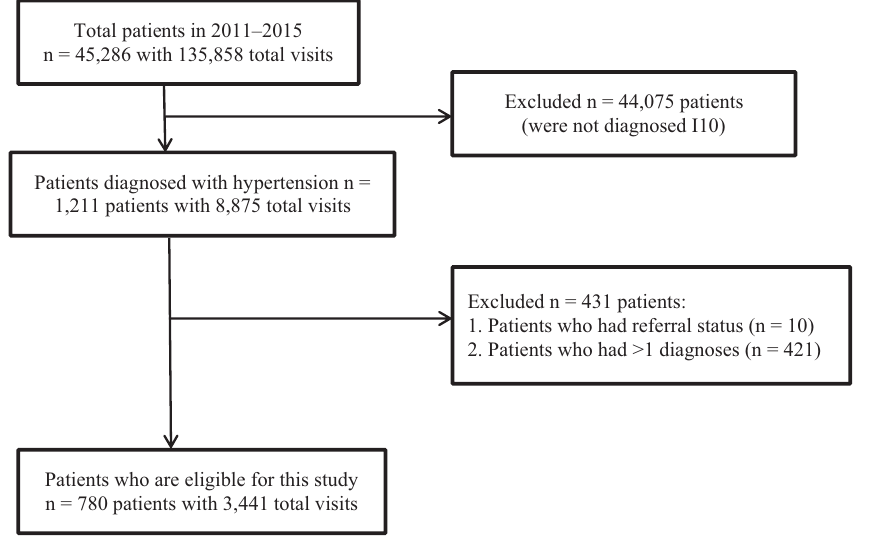
Patients who are eligible for this study n = 780 patients with 3,441 total visits Figure 1. Flowchart of patient data selection.